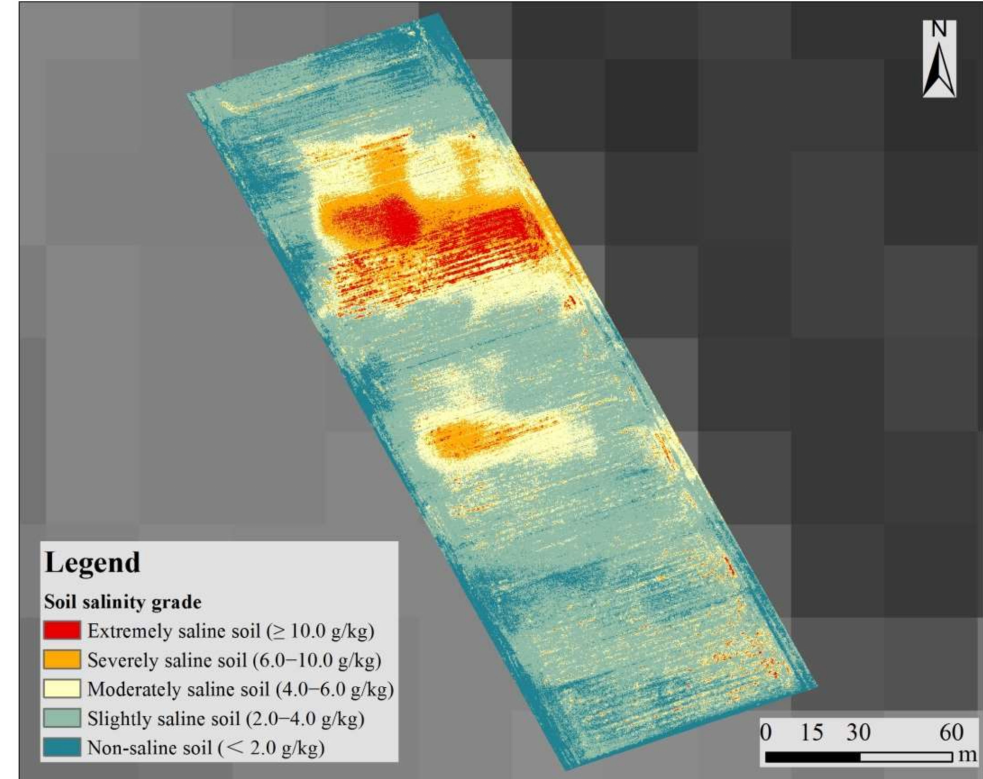
Figure 3. Retrieval map of soil salinity using the SRSI based RF